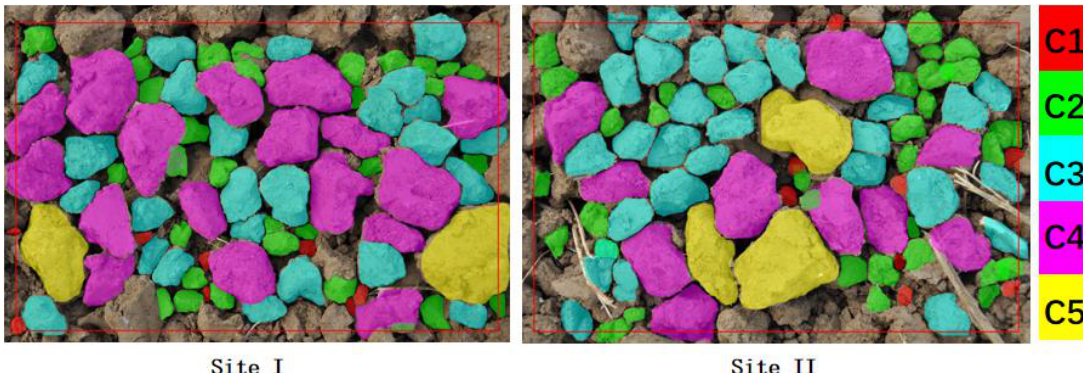
Figure 13. The effect of removing the incomplete clod from the edge.